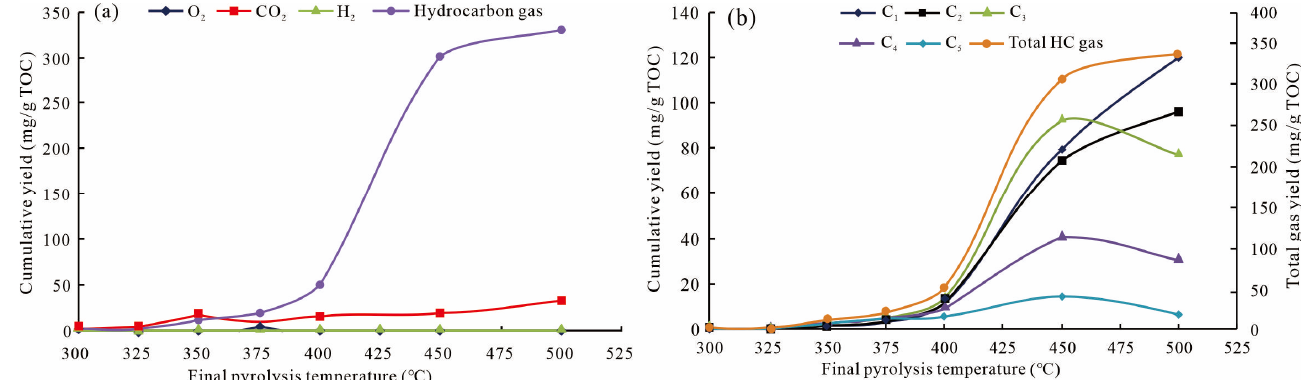
Figure 7. Yields of total gases ( a ) and hydrocarbon gases ( b ) with the increase in the temperature.